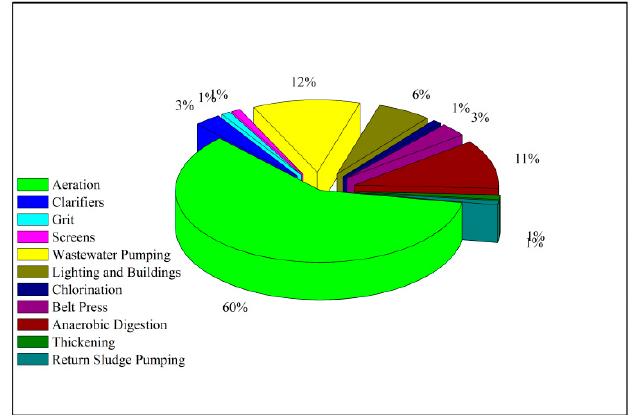
Figure 2. Energy distribution in conventional activated sludge systems [16].